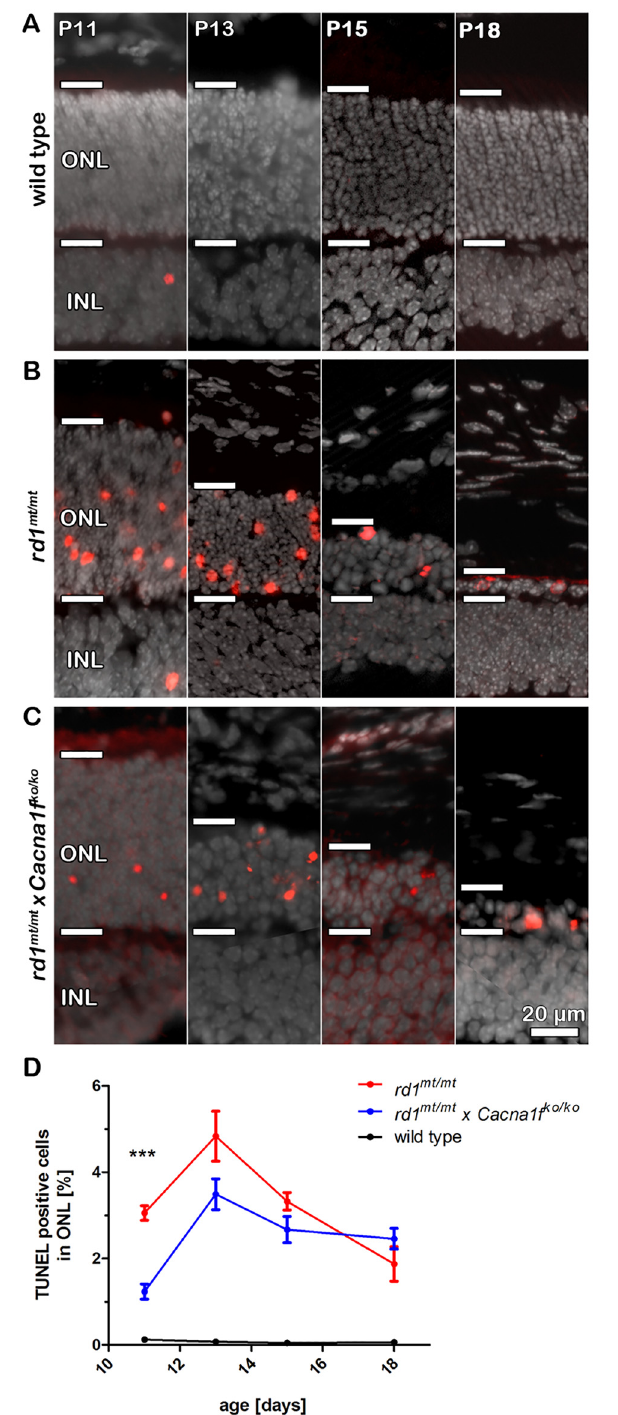
Fig 2. Knockout of Cacna1f reduces the number of dying photoreceptors in rd1 mt/mt mice. (A-C) Representative vertical cryo-sections of (A) wild type, (B) rd1 mt/mt and (C) rd1 mt/mt x Cacna1f ko/ko retinas at p11, p13, p15, and p18 stained with TUNEL (red) and DAPI (grey). The horizontal bars mark the outer nuclear layer (ONL) borders. (D) Summary graph showing the quantification of TUNEL for the different genotypes at p11, p13, p15, and 18. Each data point represents the mean percentage of TUNEL positive cells in the ONL (n = 3 – 8 per genotype and time point) ± SEM; *** p <